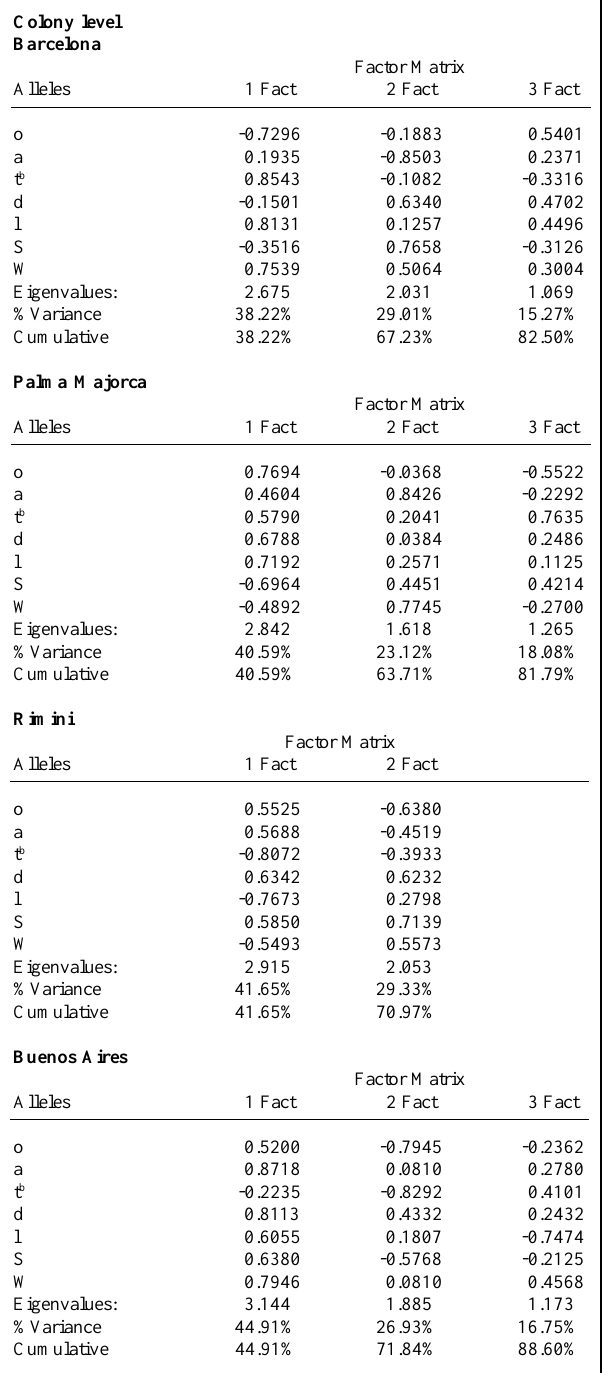
Table V - Correlation coefficients of seven morphological alleles of Felis catus in the cat colonies and subpopulations studied with the significant first axes (two or three) from an R factorial analysis. Results shown were obtained from the correlation matrix and the iterative principal factor. FACT = Factorial axes. O = orange; a = non-agouti; t b = blotched tabby; d = dilution; l = long hair; S = white spotting; W = dominant